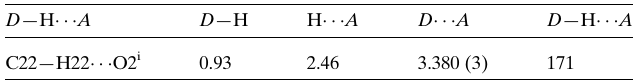
Table 1 Hydrogen-bond geometry (A˚ , (cid:2) ).